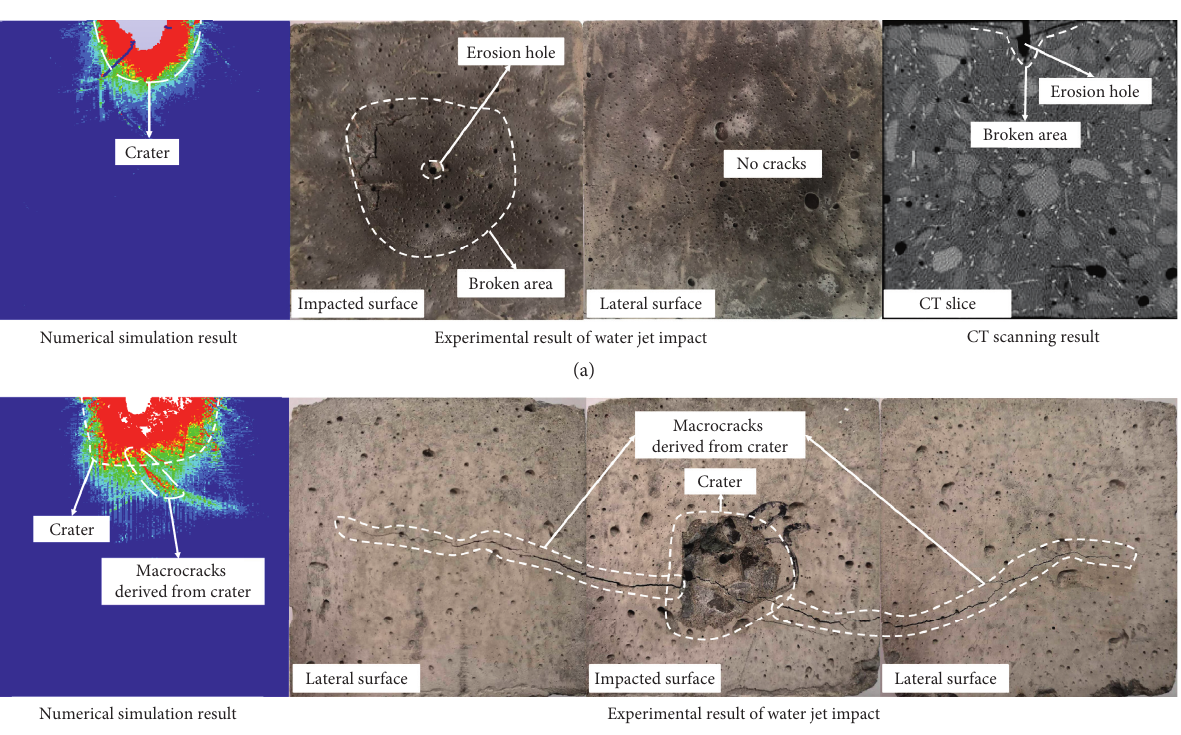
Figure 8: Comparison of results in numerical simulation and experiment: (a) SFRC and (b) ordinary